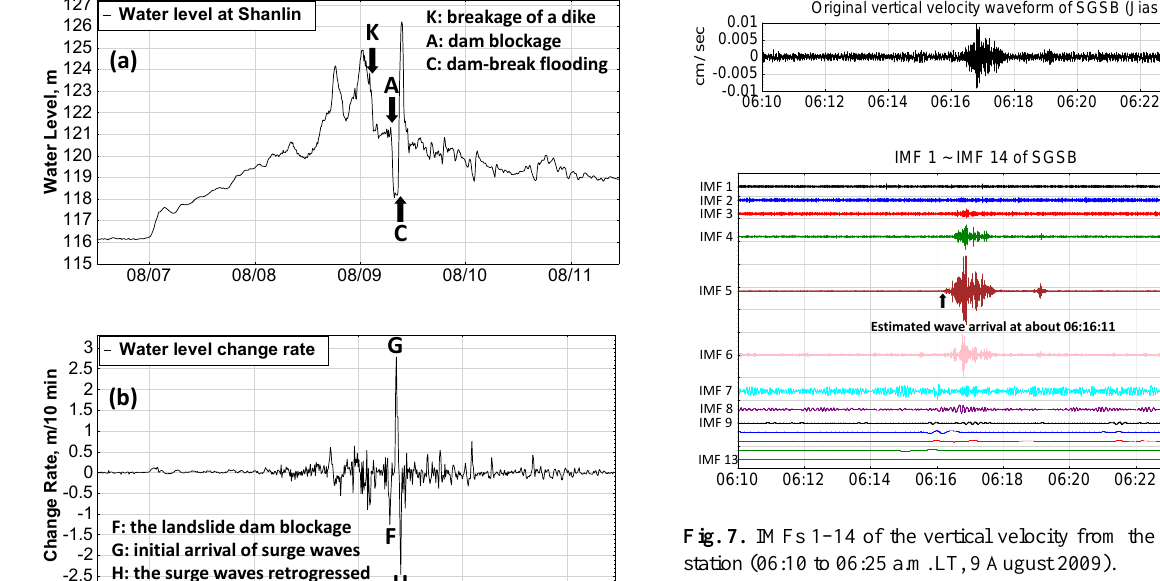
Original vertical velocity waveform of SGSB (Jiasian)